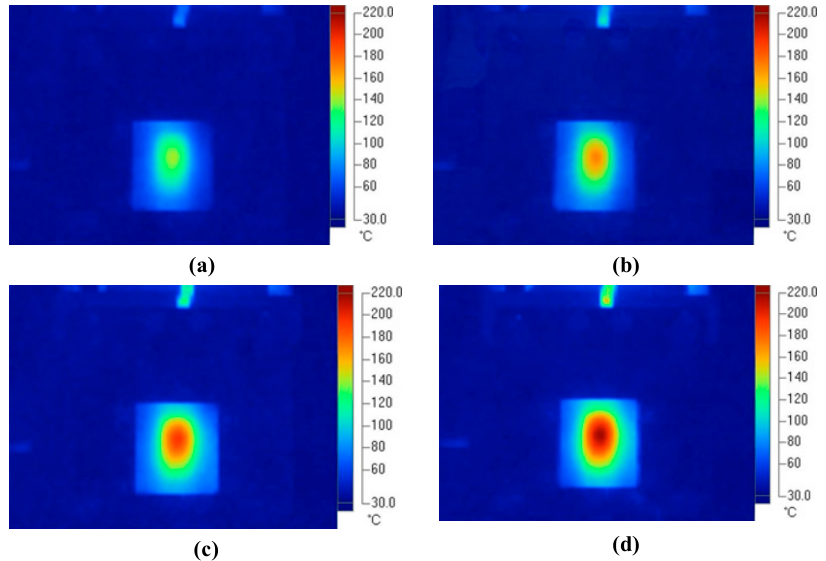
Figure 16. The mold for the front cover part with the gate heating area.